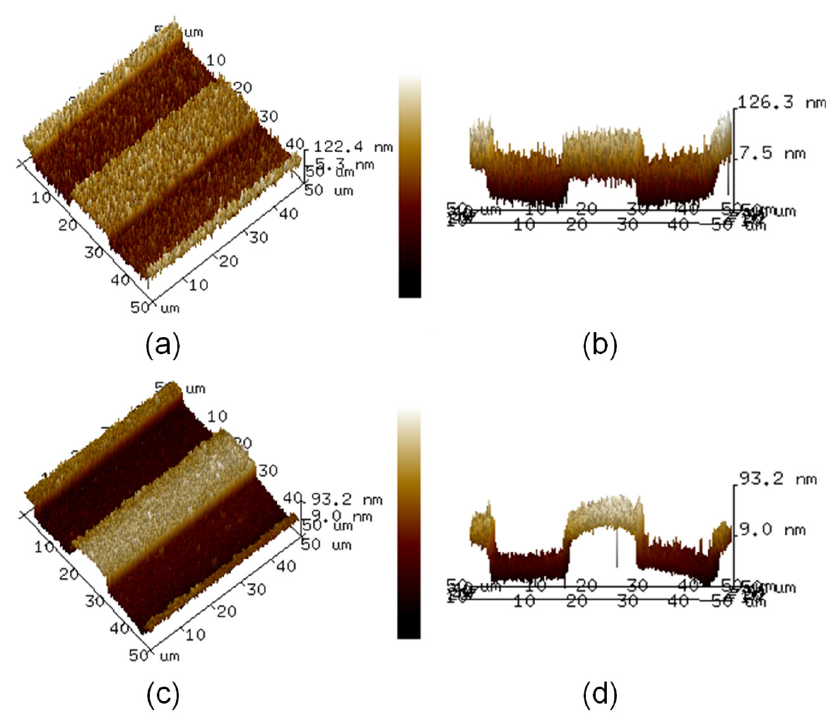
Figure 4. ( a ) Top and ( b ) side views of atomic force microscopy images of Pt ribbon deposited on Pt layer. ( c ) Top and ( d ) side views of atomic force microscopy images of TiO 2 ribbon deposited on TiO 2 compact